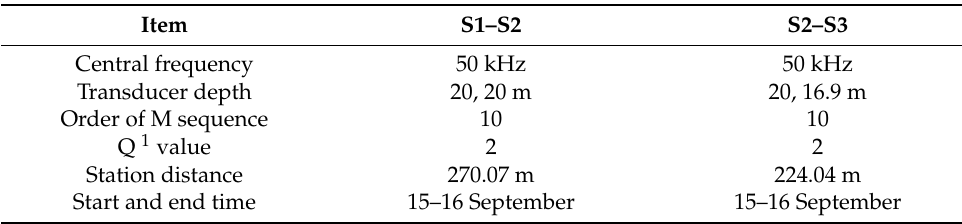
Figure 2. Experimental settings. ( a ) Experiment location and the layout of each station. The contour terrain in the figure is from 2015 data and the satellite map is from 2019 data, so they do not overlap completely. ( b ) The mooring mode of TD array. ( c ) The special mooring mode of CAT stations S1 and S2. Table 1. Parameters of the experimental